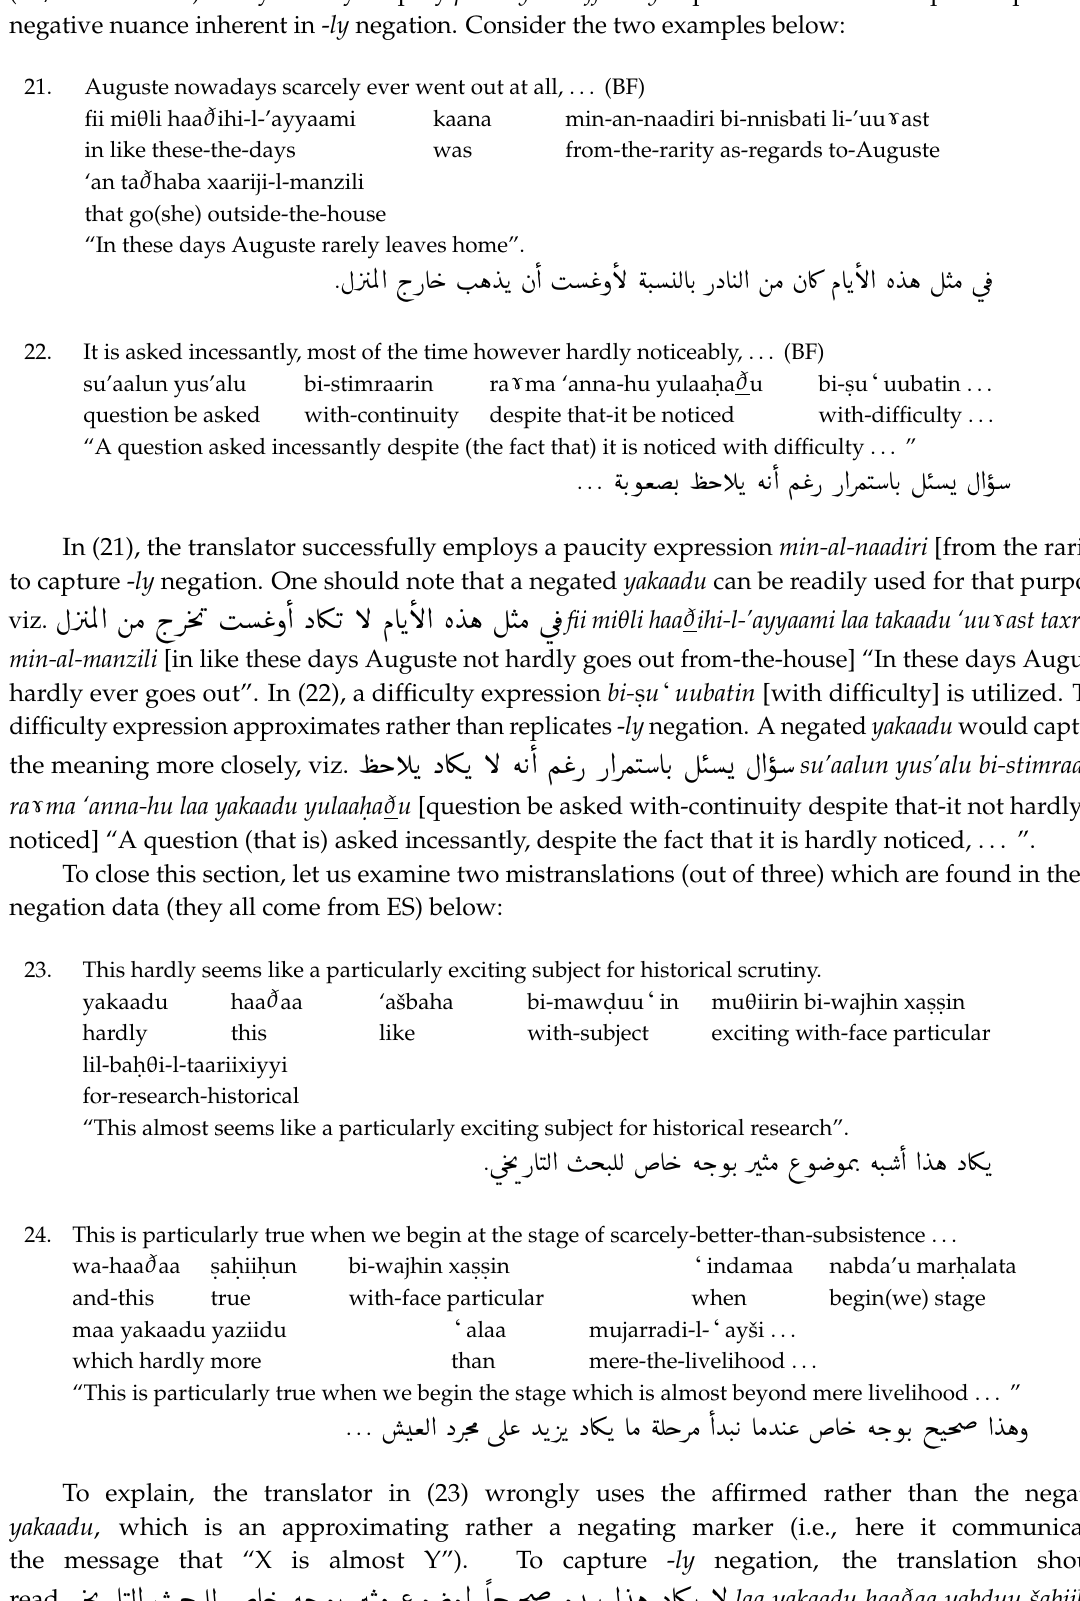
Table 4. Frequency and percentage of translation strategies in rendering -ly